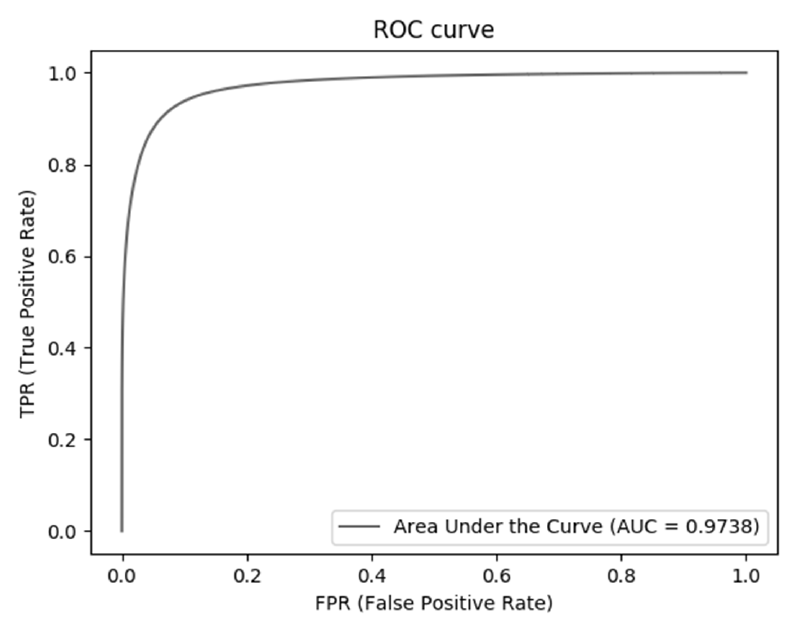
Figure 11. ROC curve of DRIVE data set .